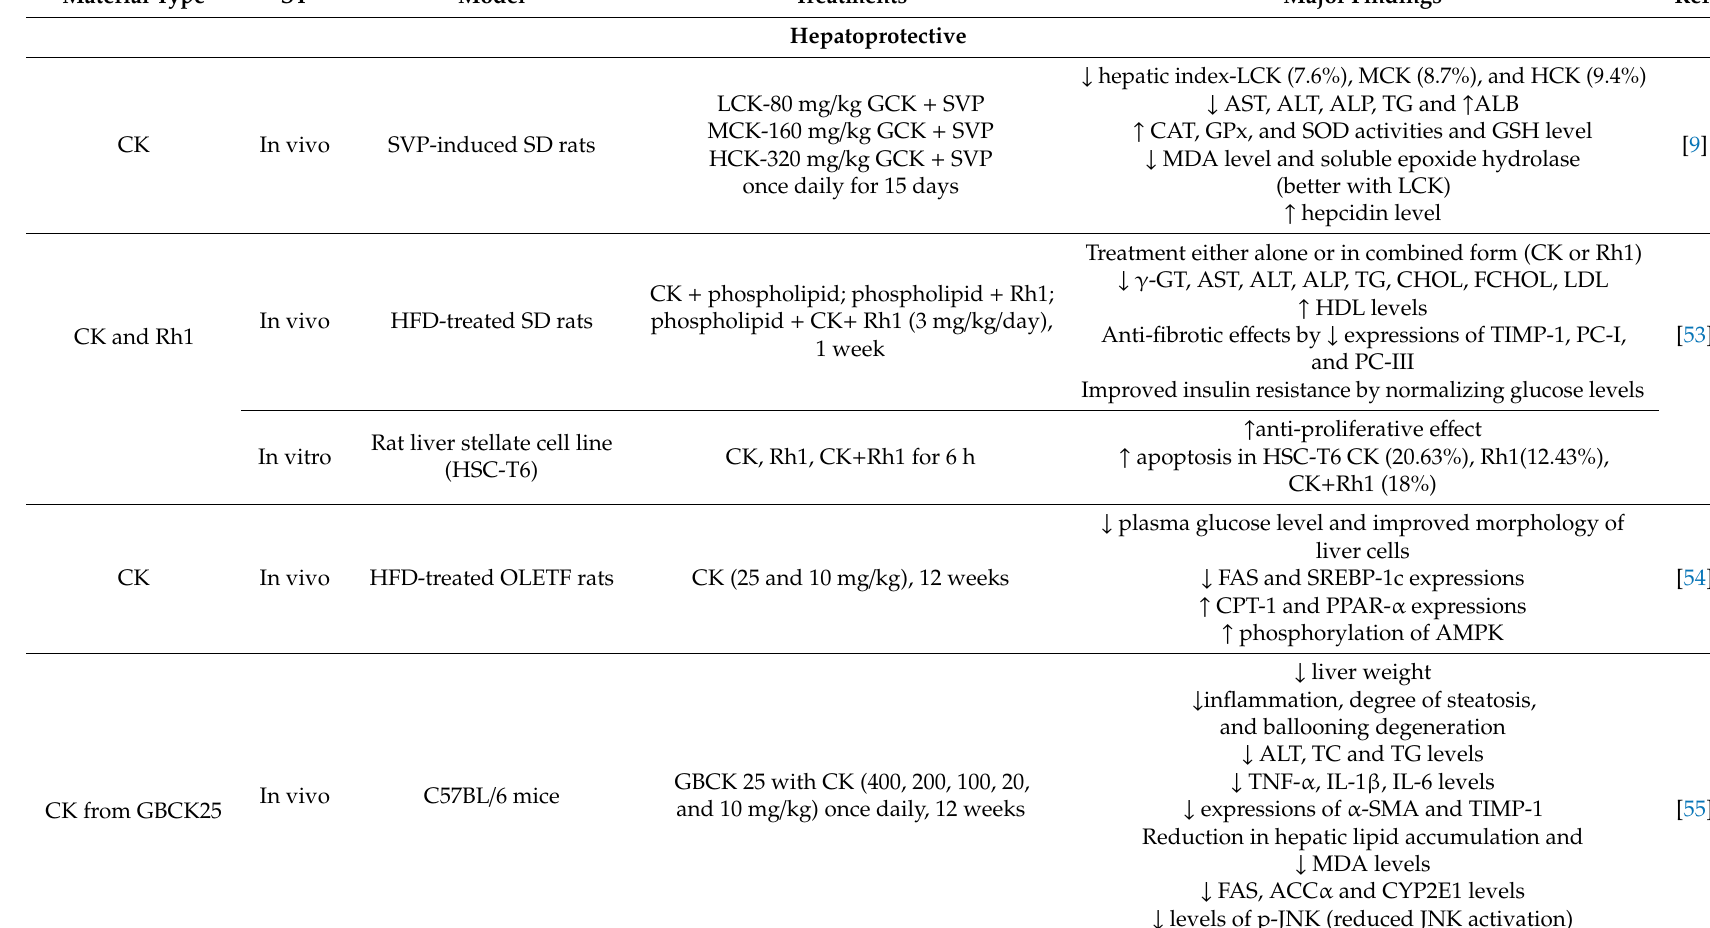
Table 3. Hepatoprotective, anti-inflammatory, anti-atherosclerosis, and anti-diabetic activities of CK and its